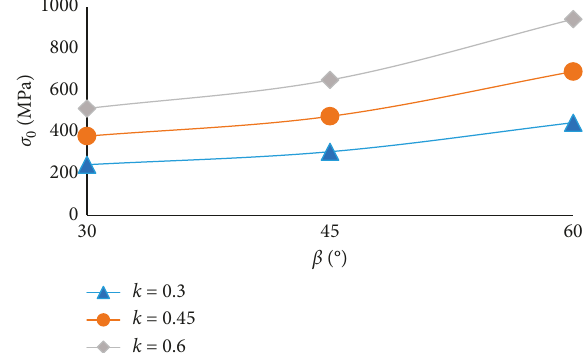
Figure 10: The stress extremum under different joint orientations and connectivity rates.